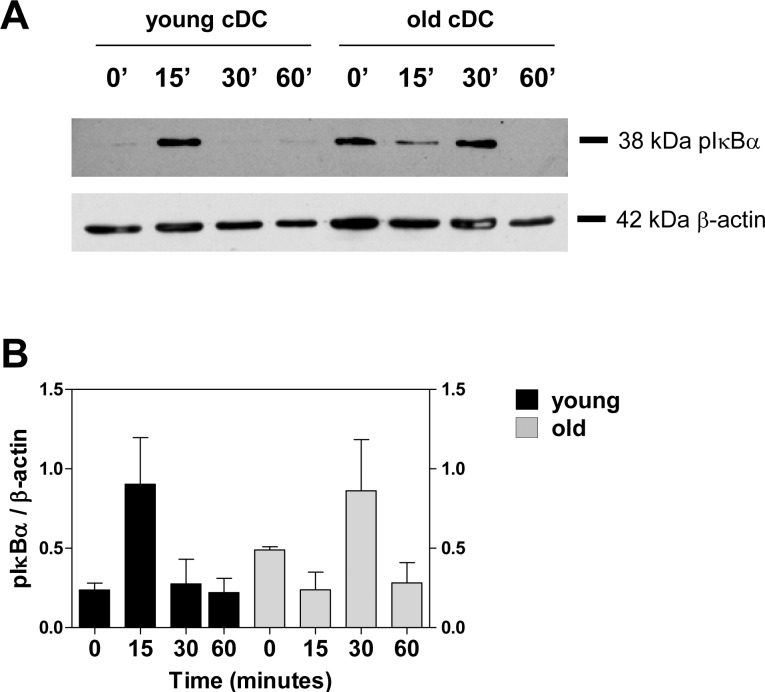
Differential phosphorylation of IκB-α in cDCs from young and old mice after TLR7 stimulation.(A) Pooled splenic cDC isolated from 3 young or old mice were incubated with 20 μg/mL polyU/DO for the indicated time. Cells were then lysed, and the level of phosphorylation of IκB-α was evaluated by Western blot using an anti-pIκB-α antibody. β-actin levels were used for loading control. (B) IOD of phosphorylated IκB-α normalized to β-actin. Data represent mean ± SEM of 2 pooled independent experiments.